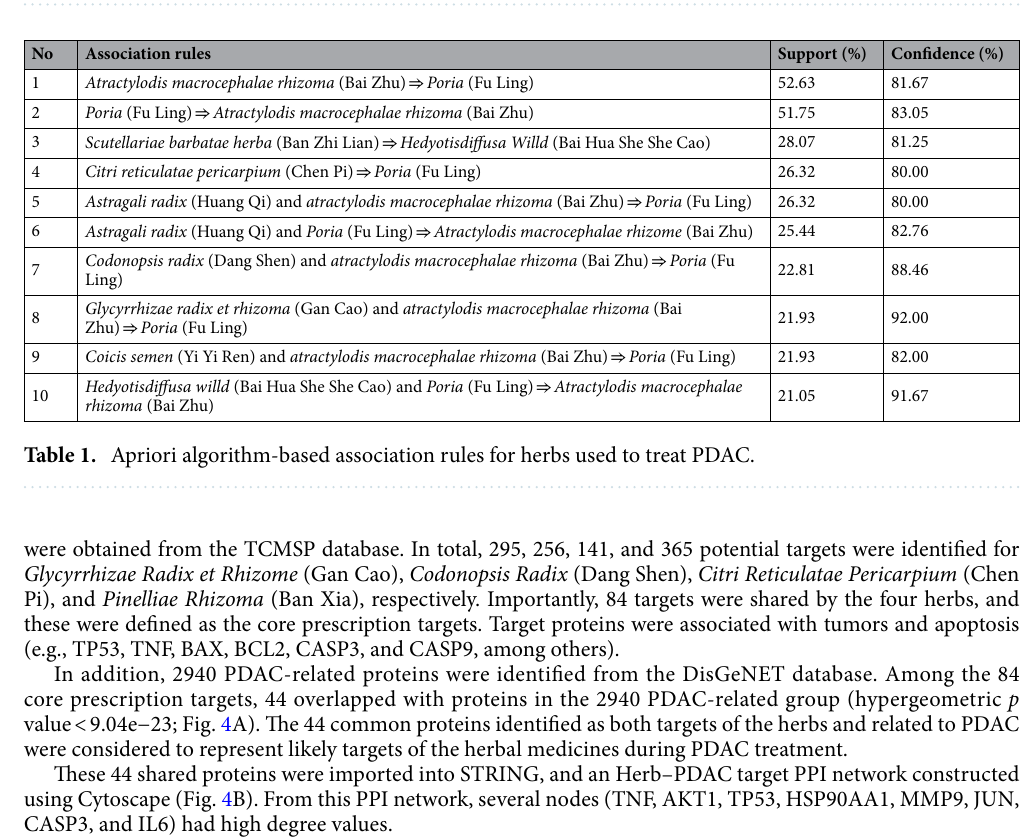
Figure 2. Frequently used herbal medicines and association rule analysis of herb combinations. ( A ) Frequencies of individual herbs. ( B ) Network diagram of association rules among the pharmacological mechanisms of herbs of interest.